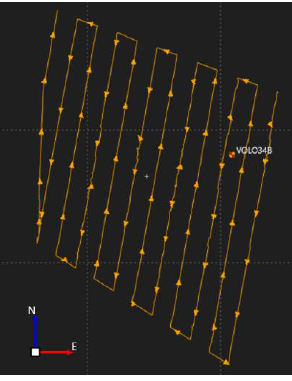
Figure 2. Flight 3 trajectory (same as Flight 1 and